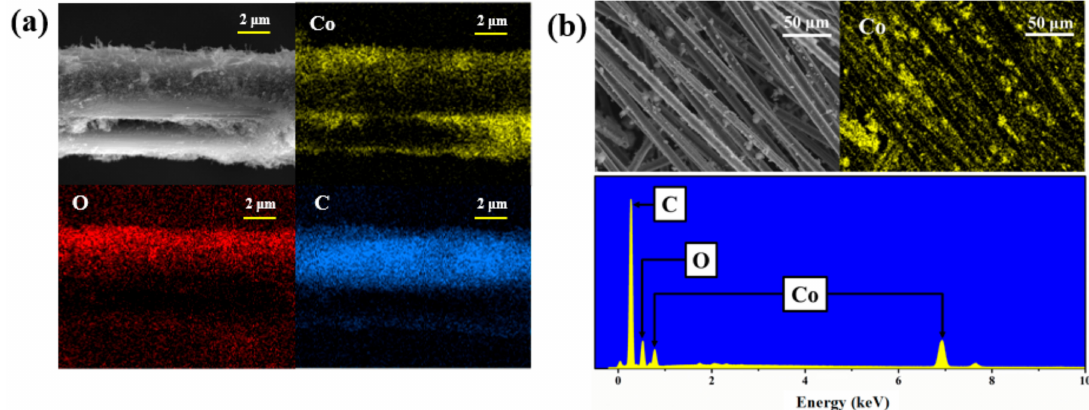
Figure 1. ( a ) EDS image of Co 3 O 4 /CF surface, ( b ) SEM and Co element distribution image of Co 3 O 4 /CP.